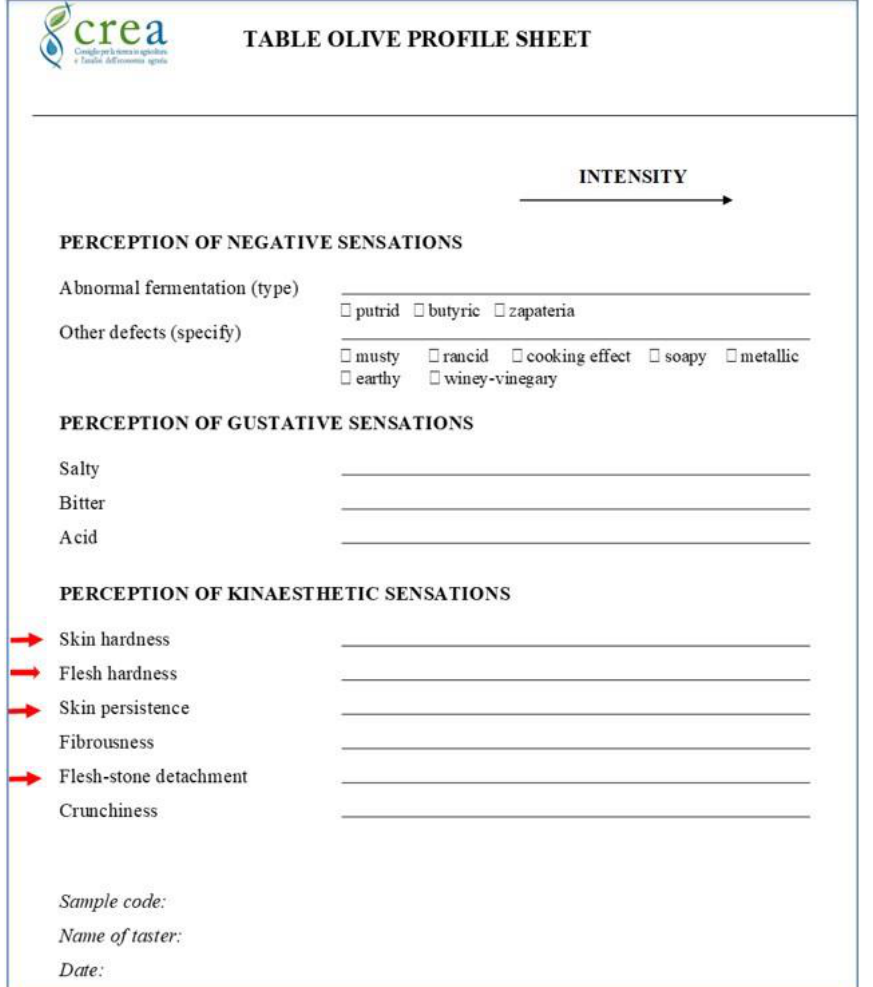
Figure 1. Experimental profile sheet based on the IOC official profile sheet (COI/OT/MO No. 1/Rev. 3 — June 2021) [15].